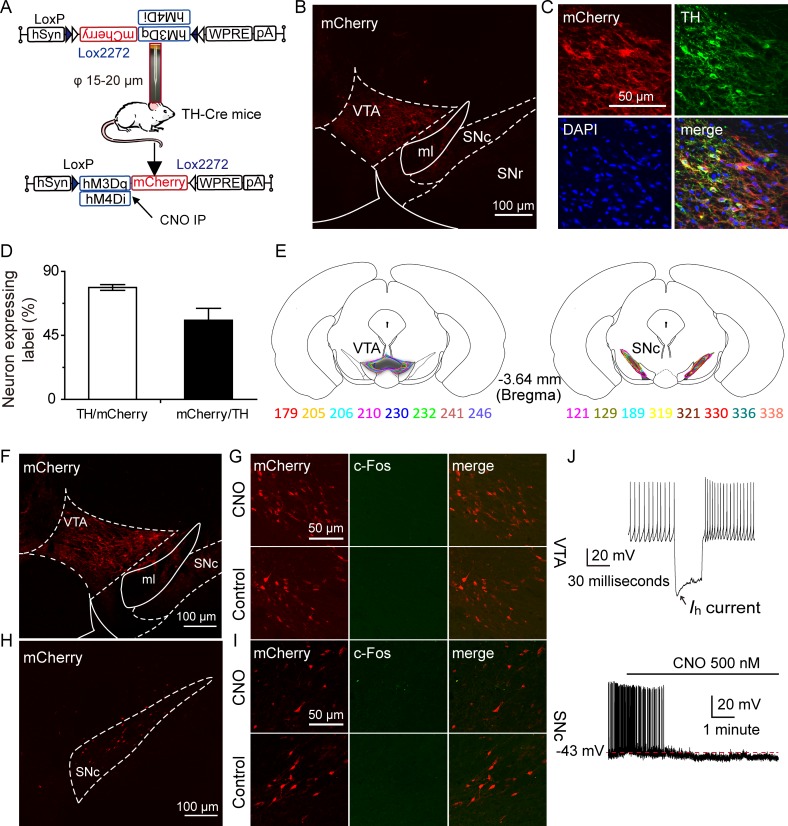
Pharmacogenetic inhibition of ventral tegmental area (VTA)/substantia nigra compacta (SNc) dopaminergic (DAergic) neurons in tyrosine hydroxylase (TH)-Cre mice.Schematic representation of Cre-dependent adeno-associated virus (AAV) vectors expressing hM3Dq/hM4Di-mCherry under the control of human synapsin (hSyn) promoter. WPRE, woodchuck hepatitis virus post-transcriptional regulatory element; CNO, clozapine-N-oxide; IP, intraperitoneal. (B) Microinjection of AAV-DIO-hM4Di-mCherry into the VTA induced hM4Di expression (red). ml, medial lemniscus; SNc, substantia nigra, compacta; SNr, substantia nigra, reticular part. (C) Representative photomicrographs of the VTA depicting mCherry expression (red), TH (green), and 4,6-diamidino-2-phenylindole (DAPI, blue) immunoreactivity and merge images (yellow) from a TH-Cre mouse microinjected with Cre-dependent AAV vectors containing hM4Di. (D) Statistics of the coexpression of TH and mCherry immunofluorescence of VTA neurons (n = 3, per group). (E) Drawings of superimposed AAV-injected area in the VTA (left, n = 8) and SNc (right, n = 8) of TH-Cre mice with different colors. (F, H) Representative photomicrographs of mCherry expression after microinjection of AAVs containing hM4Di into the VTA (F) and SNc (H). (G, I) CNO (G, I; top) and saline (G, I; bottom) did not induce c-Fos expression in hM4Di-expressing DAergic neurons in VTA (G) or SNc (I). (J) In TH-Cre mice, the firing property of a recorded VTA hM4Di/mCherry-positive DAergic neuron with hyperpolarization-activated cation current (Ih) (top) and CNO perfusion inhibited its firing rate (bottom). Underlying data can be found in S1 Data.